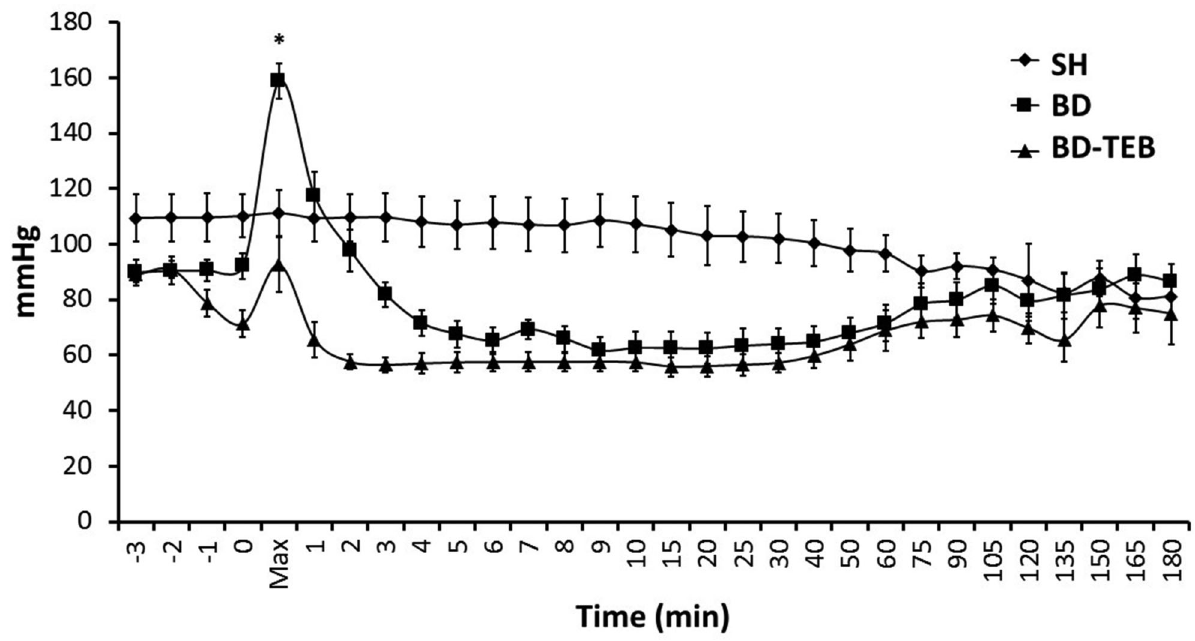
Figure 1 - Mean arterial pressure of sham-operated rats (SH), brain-dead non-treated rats (BD), and brain-dead rats under thoracic epidural blockade (BD-TEB) 180 minutes after the surgical procedures. The animals were monitored over time. The data are presented as the means ± SEM; ANOVA p o 0.001; * p o 0.05 vs. the other